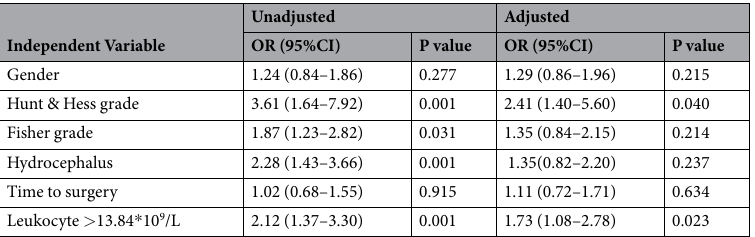
Table 3. Predictors of DIND for ruptured CA in multivariate model. OR = odds ratio; CI = confidence